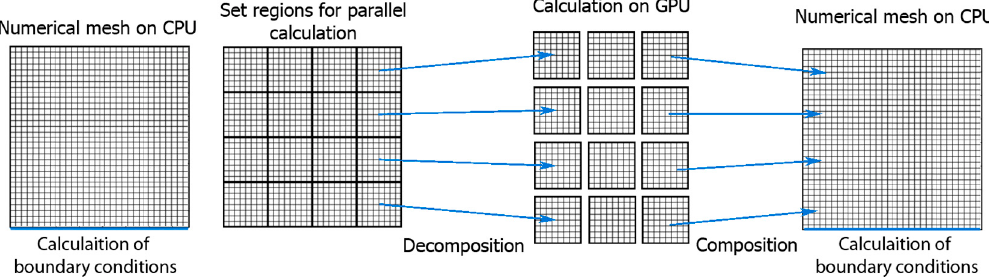
Figure 3. Numerical mesh CPU-GPU decomposition.